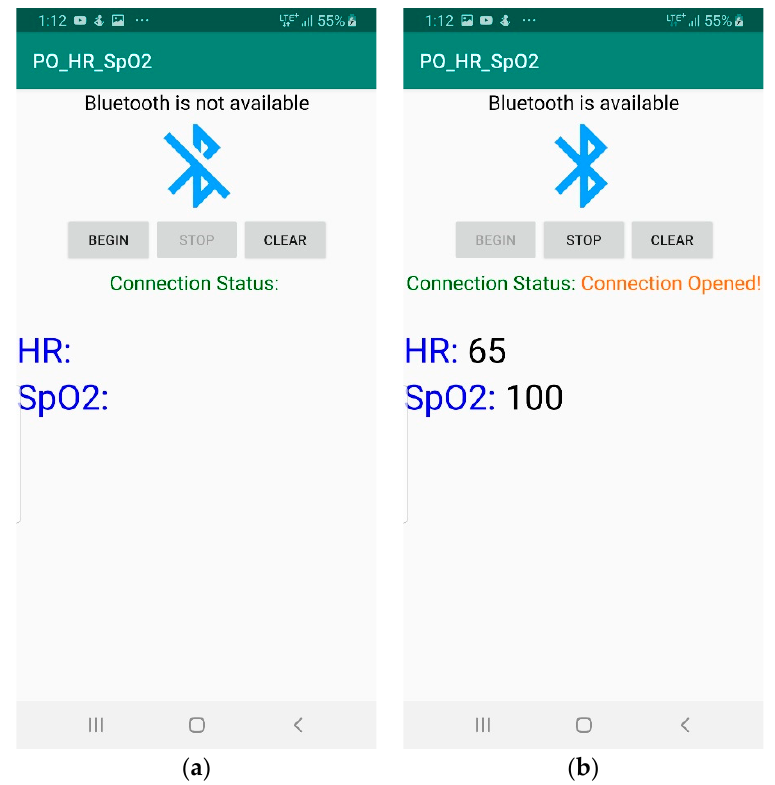
Figure 19. Smartphone app for the display of PR and SpO 2 . ( a ) Bluetooth off ( b ) Bluetooth on